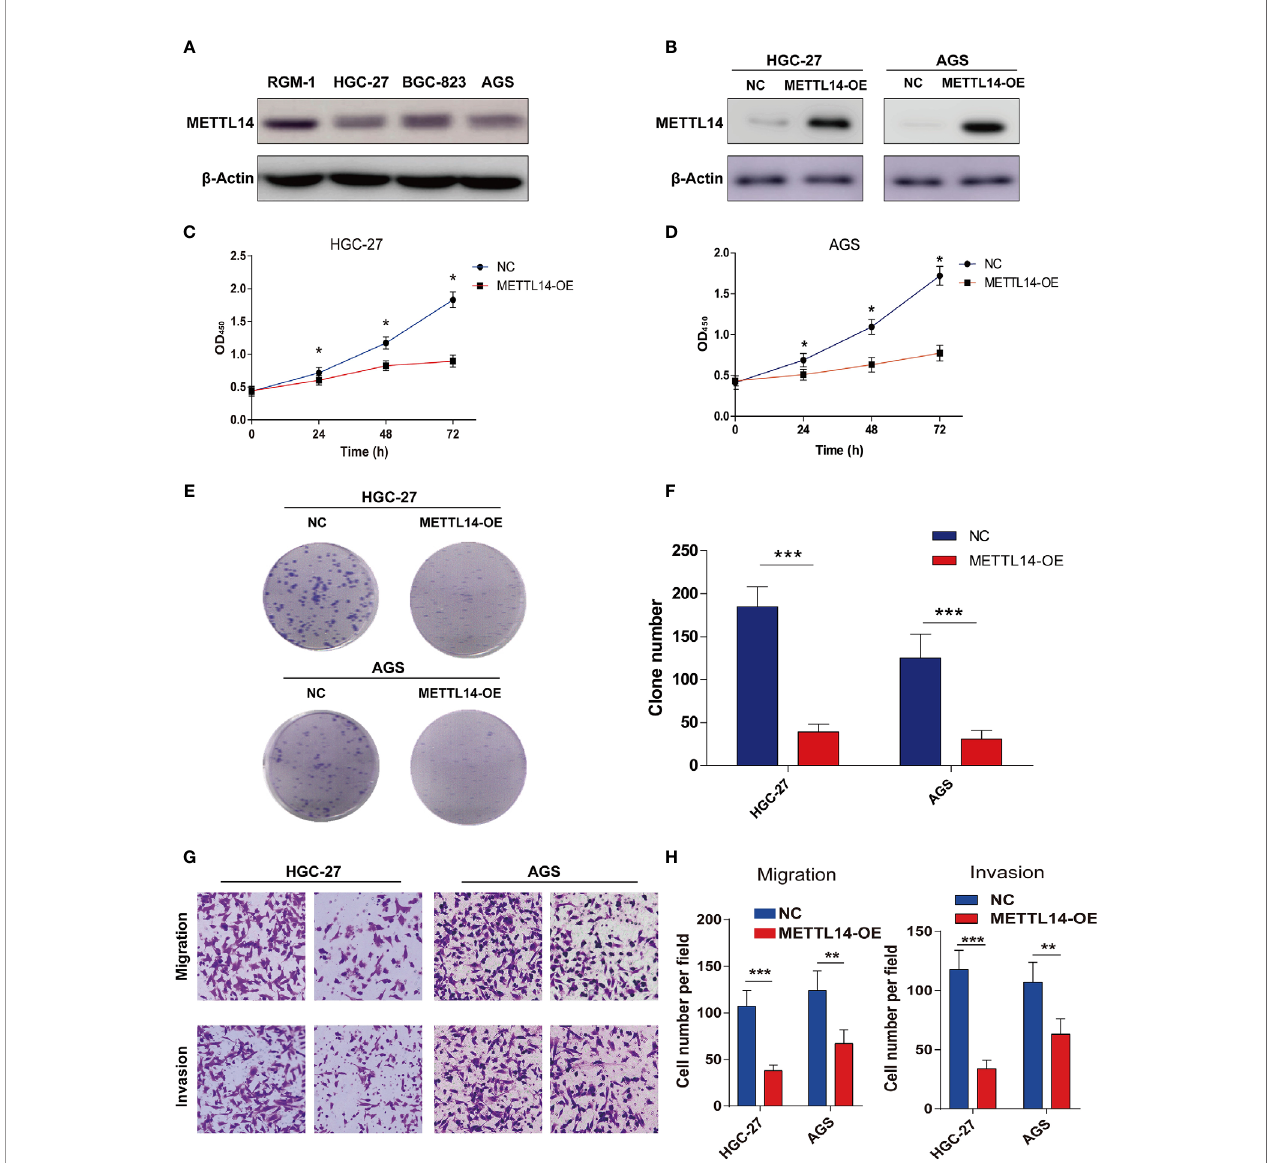
FIGURE 2 | Overexpression of METTL14 inhibited proliferation, migration and invasion of STAD. (A) METTL14 was lower expression in STAD cell lines (HGC-27, BGC-823, AGS) compared with normal gastric mucosa cell line RGM-1. (B) Validation the expression level of METTL14 after the over expression METTL14 in HGC- 27 and AGS cells. (C , D) CCK8 were used to detect the cell viability between negative control (NC) and METTL14 overexpression (METTL14-OE) in HGC-27 and AGS cells (* P < 0.05). (E , F) Colony formation assay were used to detect the proliferation of HGC-27 and AGS cells after METTL14 overexpression (*** P < 0.001). (G, H) Transwell assay were used to detect the migrative and invasive ability of HGC-27 and AGS cells after METTL14 overexpression (** P < 0.01; *** P <